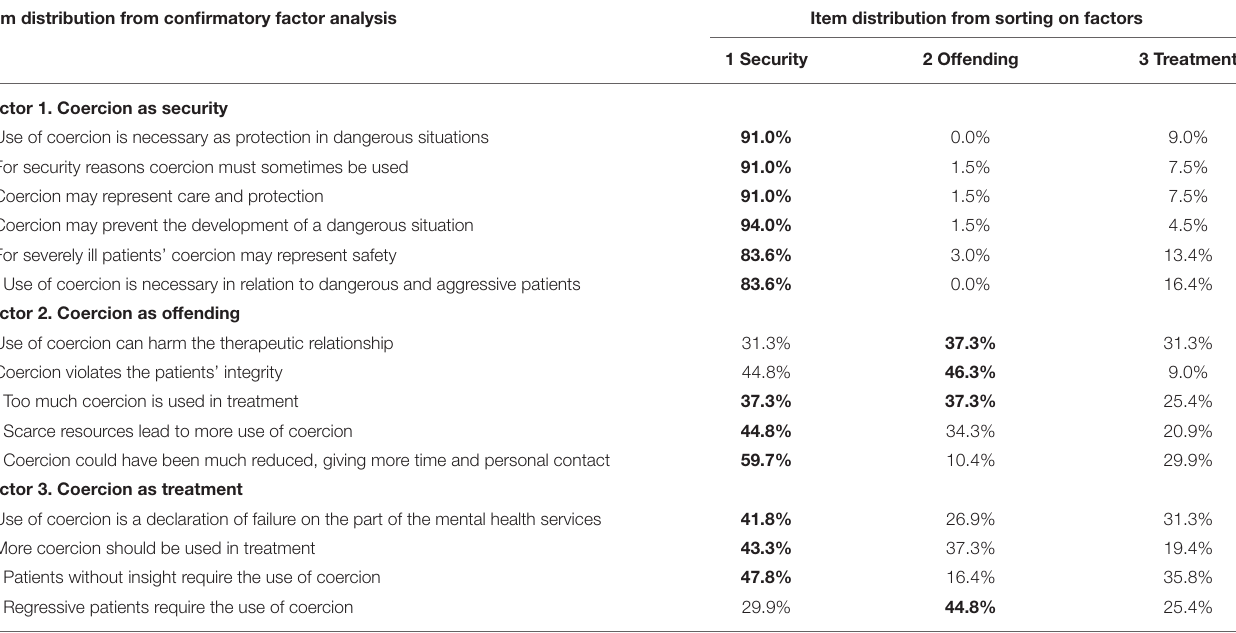
TABLE 4 | Face validity of staff attitude to coercion scale (SACS): Sorting of items (%) on three factors by 67 medical personnel in psychiatric departments. Item distribution from confirmatory factor